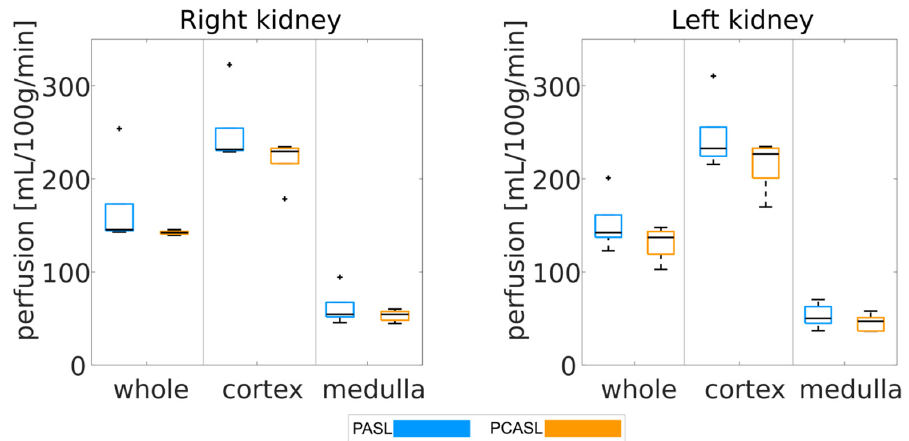
Figure 4. Mean renal perfusion averaged over the whole kidney, the cortex, and the medulla for all considered models with healthy perfusion. The black line in each boxplot shows the median of the distribution of mean perfusion across all models. The top and bottom part of each boxplot represent the 25th and 75th percentiles. The boxplots’ whiskers extend to the highest and lowest data points not considered as outliers. Outliers are shown a black ‘+’.